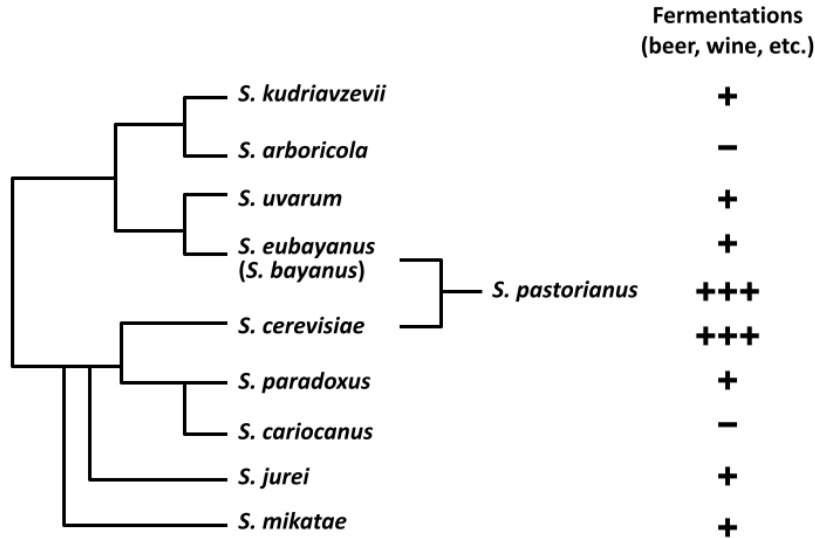
Figure 1. Sss phylogeny and extent of use in alcoholic beverage fermentations. Saccharomyces bayanus is listed in parenthesis to indicate it was derived from multiple hybridization events [42]. S. pastorianus is shown as a genetic hybrid of S. eubayanus and S. cerevisiae [21]. Use in fermented beverages is indicated with plus signs (+) for current commercial use, with S. cerevisiae and S. pastorianus exhibiting the most ubiquitous use in beer, and negative signs ( − ) for no known use. S. cariocanus is known to be harboring just four translocated chromosomes different than S. paradoxus [43]. S. jurei